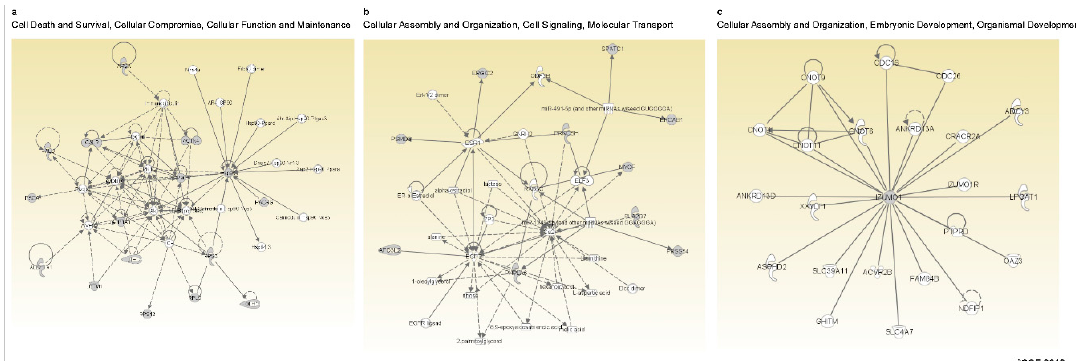
Figure 2. Top networks associated with differentially expressed proteins in group 1 vs. group 3. ( a ) Cell death and survival, cellular compromise, cellular function, and maintenance; ( b ) cellular assembly and organization, cell signaling, molecular transport; and ( c ) cellular assembly and organization, embryonic development, organismal development. Group 1: neat semen samples with round cells and leukocytes ≥ 1 × 10 6 /mL. Group 3: neat semen samples with round cells < 1 × 10 6 /mL.